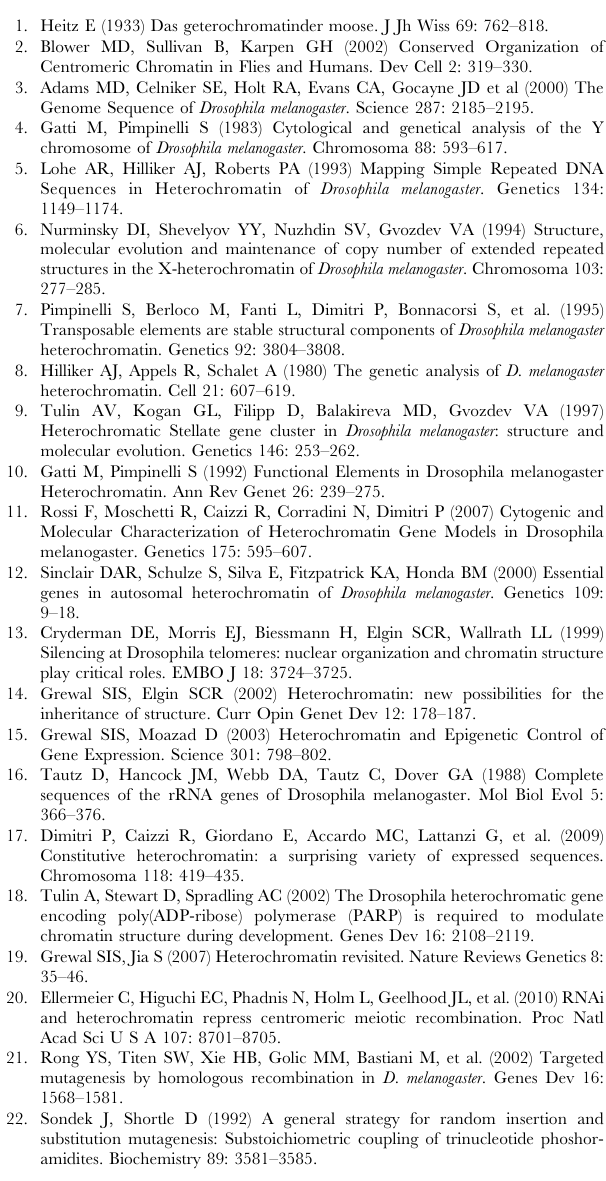
Figure S1 Evolutionary conservation for Tim17b